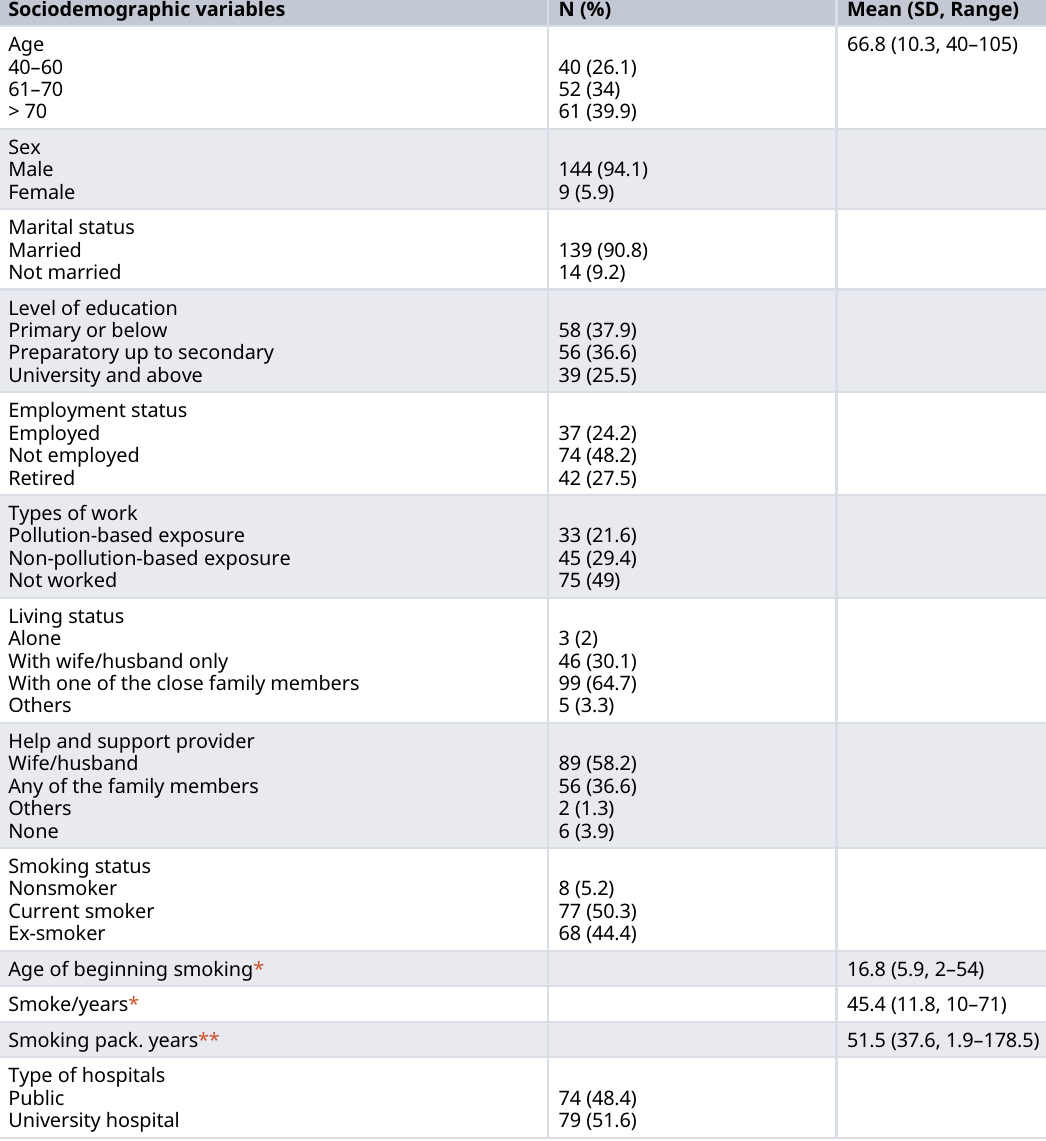
Table 1. Sociodemographic characteristics of participants (N =